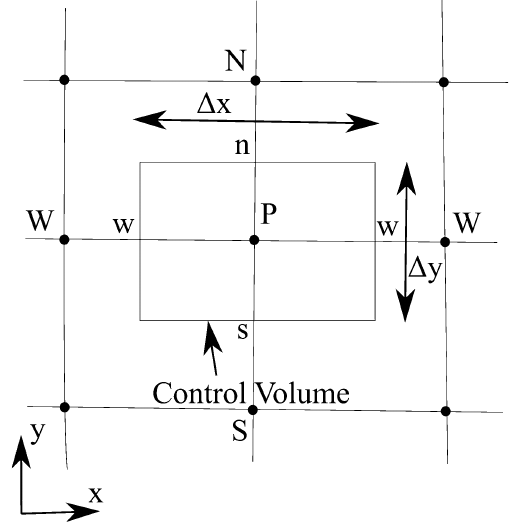
Fig. 2 Control volume for the two-dimensional